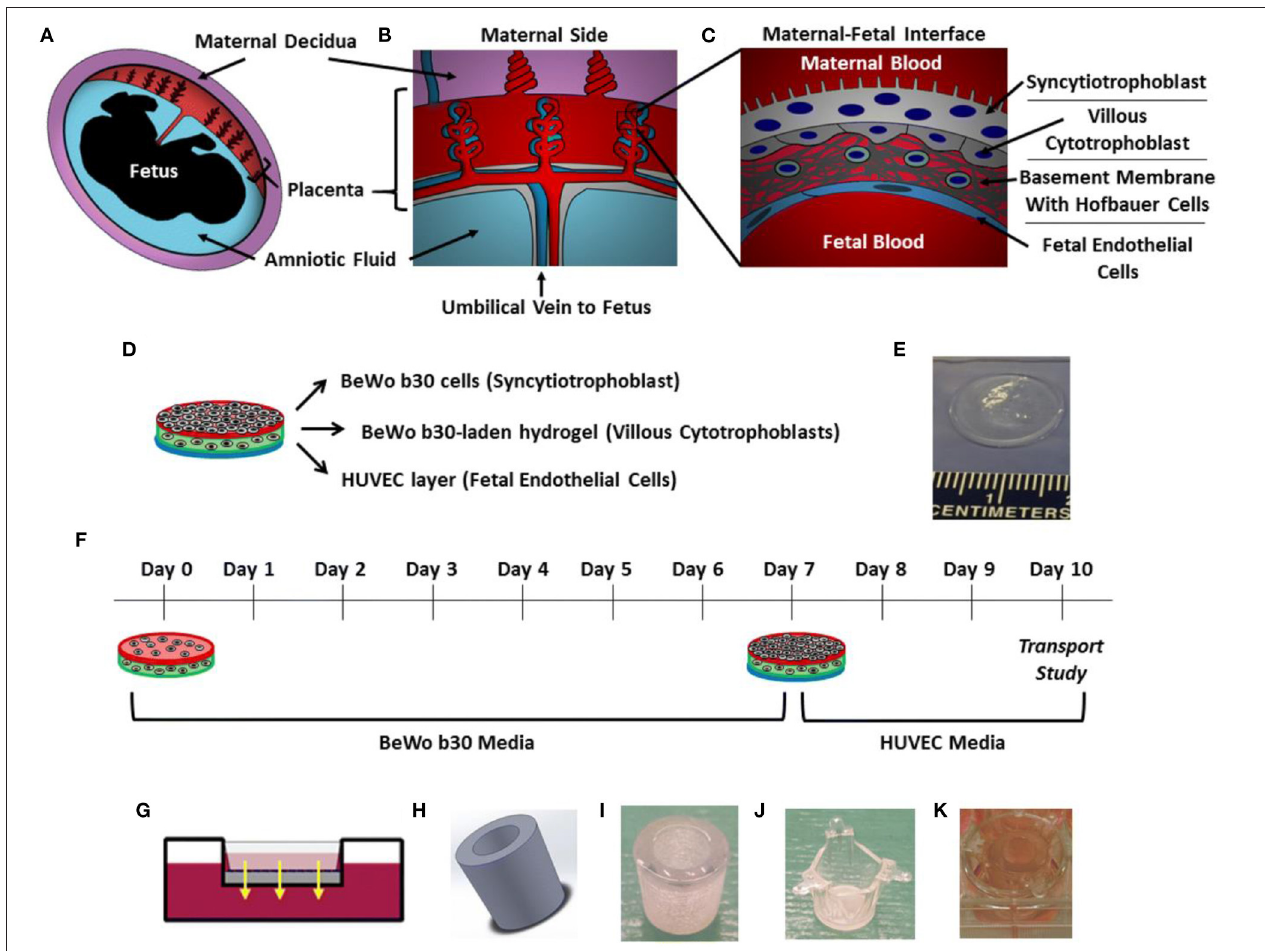
FIGURE 8 | A model of the BPB, and the system used to culture BeWO b30 and HUVEC cells to perform a transport assay. (A) A diagram of the maternal decidua, along with the (B) maternal side and the (C) maternal-fetal interface. A (D) diagram and (E) image of the BPB model used. (F) A timeline of culturing BeWo b30 cells (day 0) and HUVEC cells (day 7) before the performed assays (day 10). (G) Schematic transport assay, (H,I) plug used in transwell insert, (J) transwell insert, and (K) image of transport assay. This figure is reprinted under the terms of the Creative Commons Attribution License from Arumugasaamy et al. (2018).